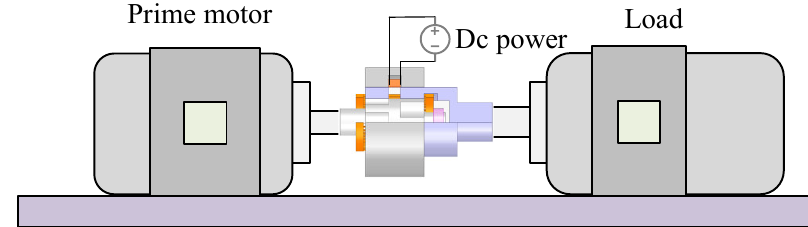
Figure 3. The working platform of the HTR-ASD.